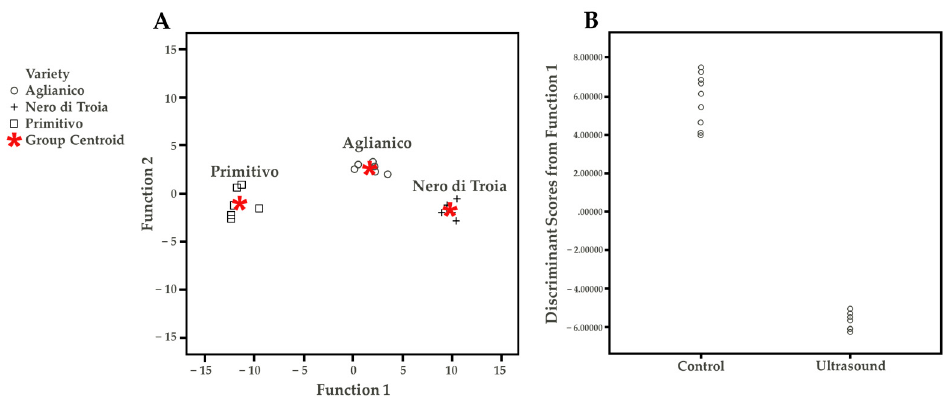
Figure 4. ( A ) Discriminant function plot considering wine cultivar. ( B ) Discriminant function plot considering the treatment.